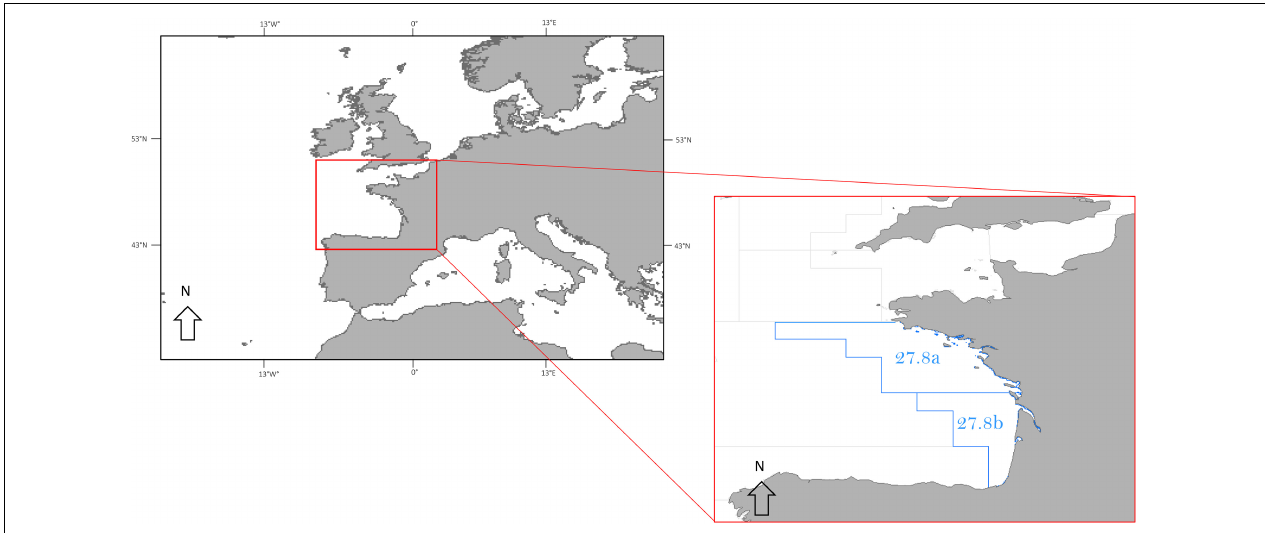
FIGURE 2 | North-East Atlantic Ocean including study area (ICES subareas 27.8.a and 27.8.b) in blue boxes. ICES, International Council for the Exploration of the Sea.